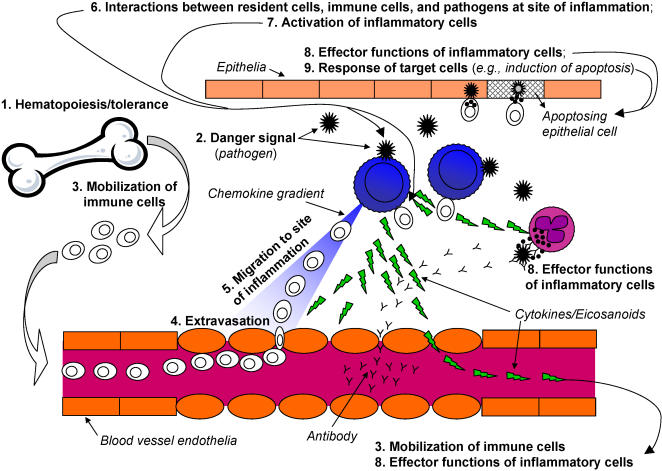
Development of an immune response.Depicted is a schematic representation of an immune response to a generic pathogenic insult. The phases of immune responses (described in Table 2) are shown in bold. Additional aspects not shown are the involvement of secondary lymphoid tissues for initial T cell and B cell activation by dendritic cells that migrate from the site of inflammation to lymph nodes and other secondary lymphoid structures. The resolution of immune responses, immunological memory, and homeostasis are also not depicted.